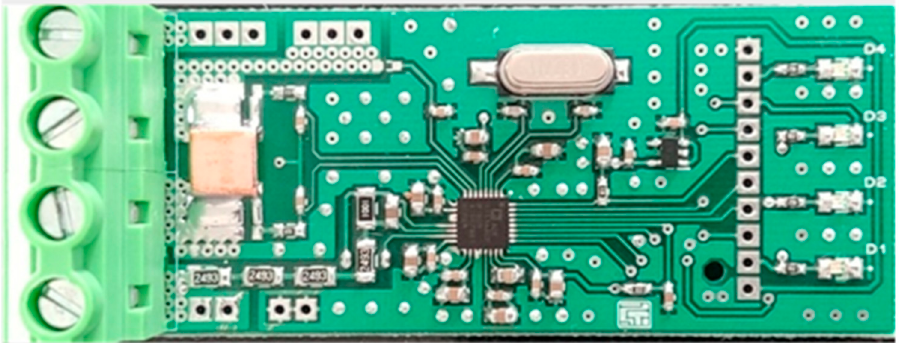
Figure 2. The measuring circuit